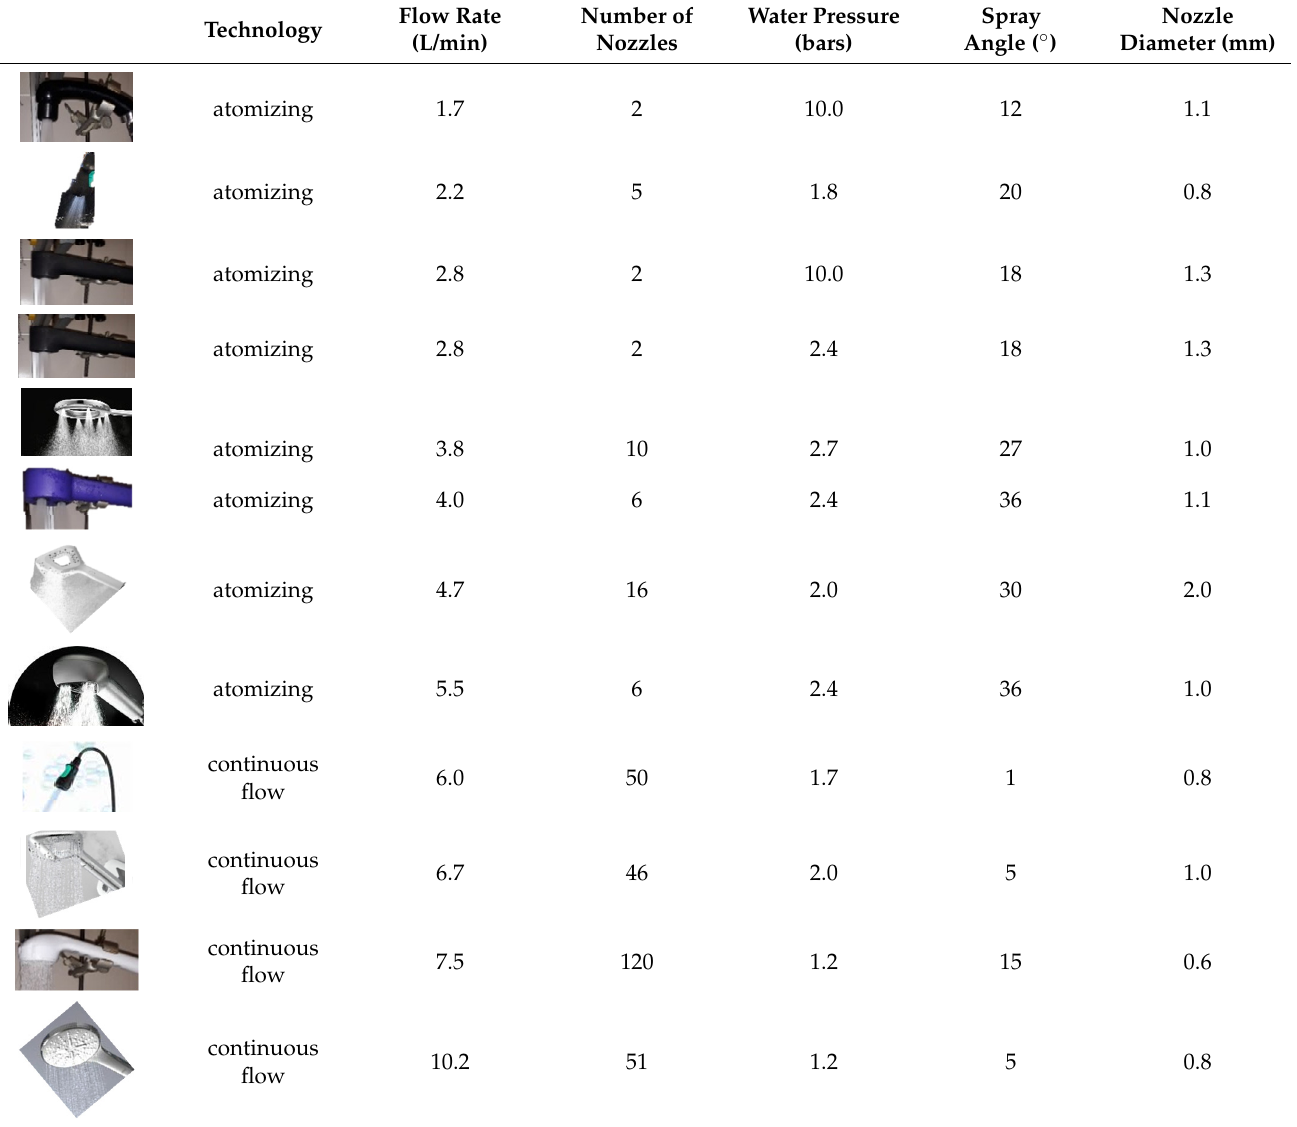
Table 1. Characteristics of the showerheads tested, ranked by water flow rate. Technology